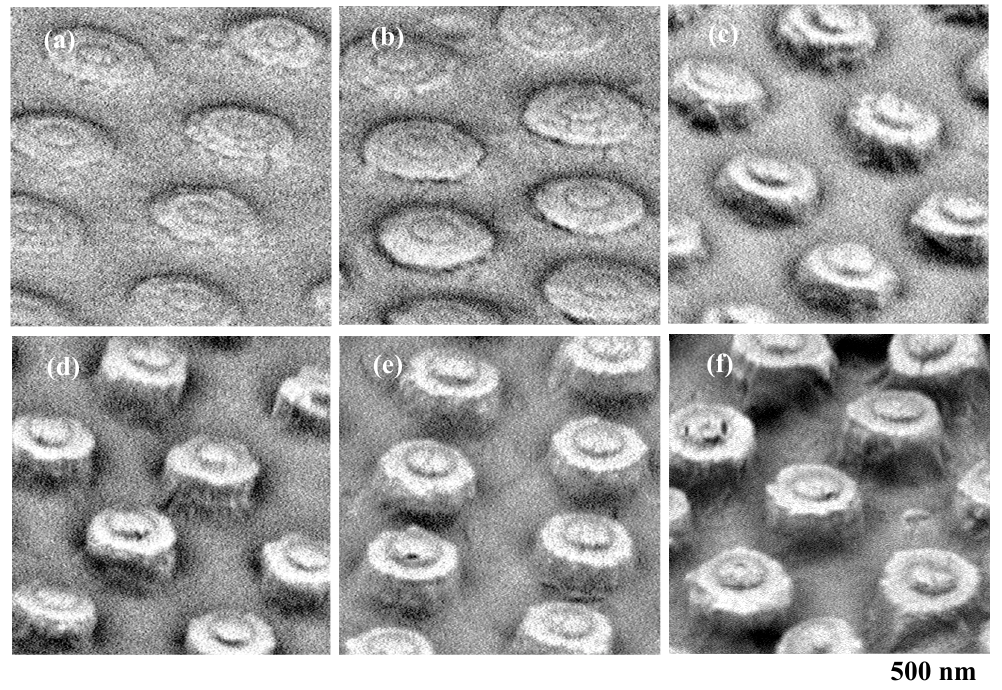
Figure 3. SEM images of the photochemical micro-/nano-swelling formed on silicone rubber after HF chemical etching. The pulse-repetition rate was variously set to ( a ) 50, ( b ) 20, ( c ) 10, ( d ) 6, ( e ) 4, and ( f ) 2 Hz.